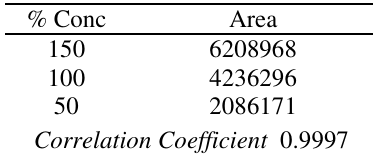
Figure 4 . Ibutilide fumarate accuracy studies linearity